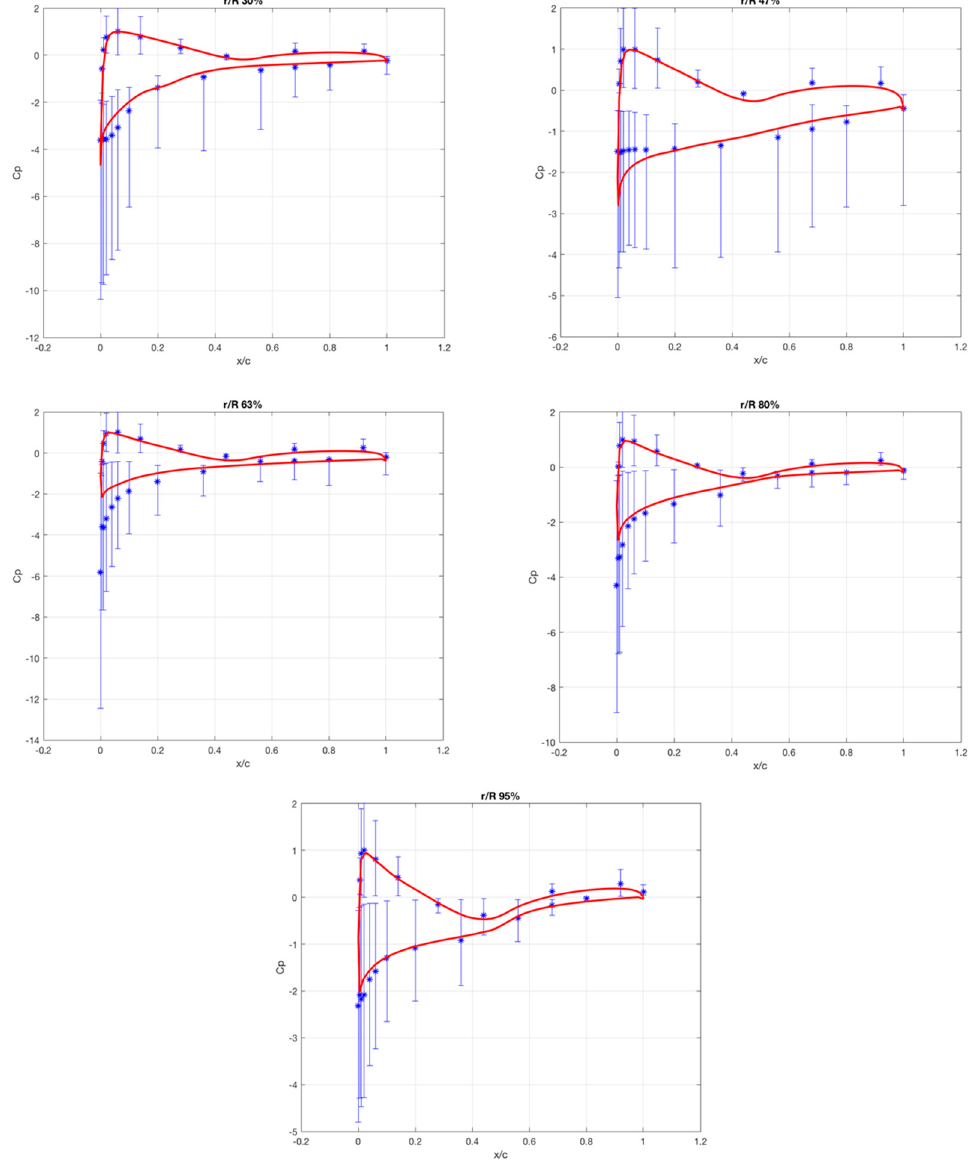
Figure 13. Pressure coefficient distribution for 10 m/s wind speed: Pressure coefficient at 30% span, Pressure coefficient at 47% span, Pressure coefficient at 63% span, Pressure coefficient at 80% span, Pressure coefficient at 95% span (from left-hand top to right-hand bottom).